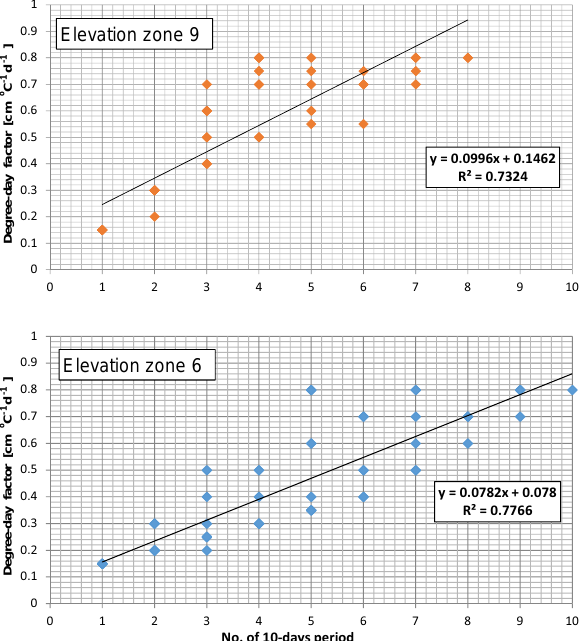
Figure 3. Increase of degree-day factors with time (10-days pe- riods) after melting start for elevation zones 6 and 9. Degree-day factors are obtained by diagnostic calibration.